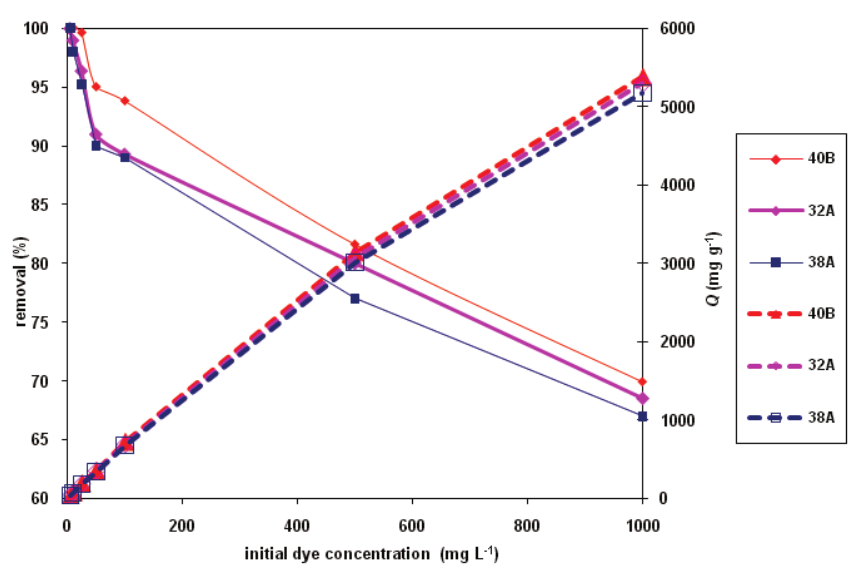
Fig. 4 – Effect of initial dye concentration on both the dye removal percentage and capacity using three biopolymers